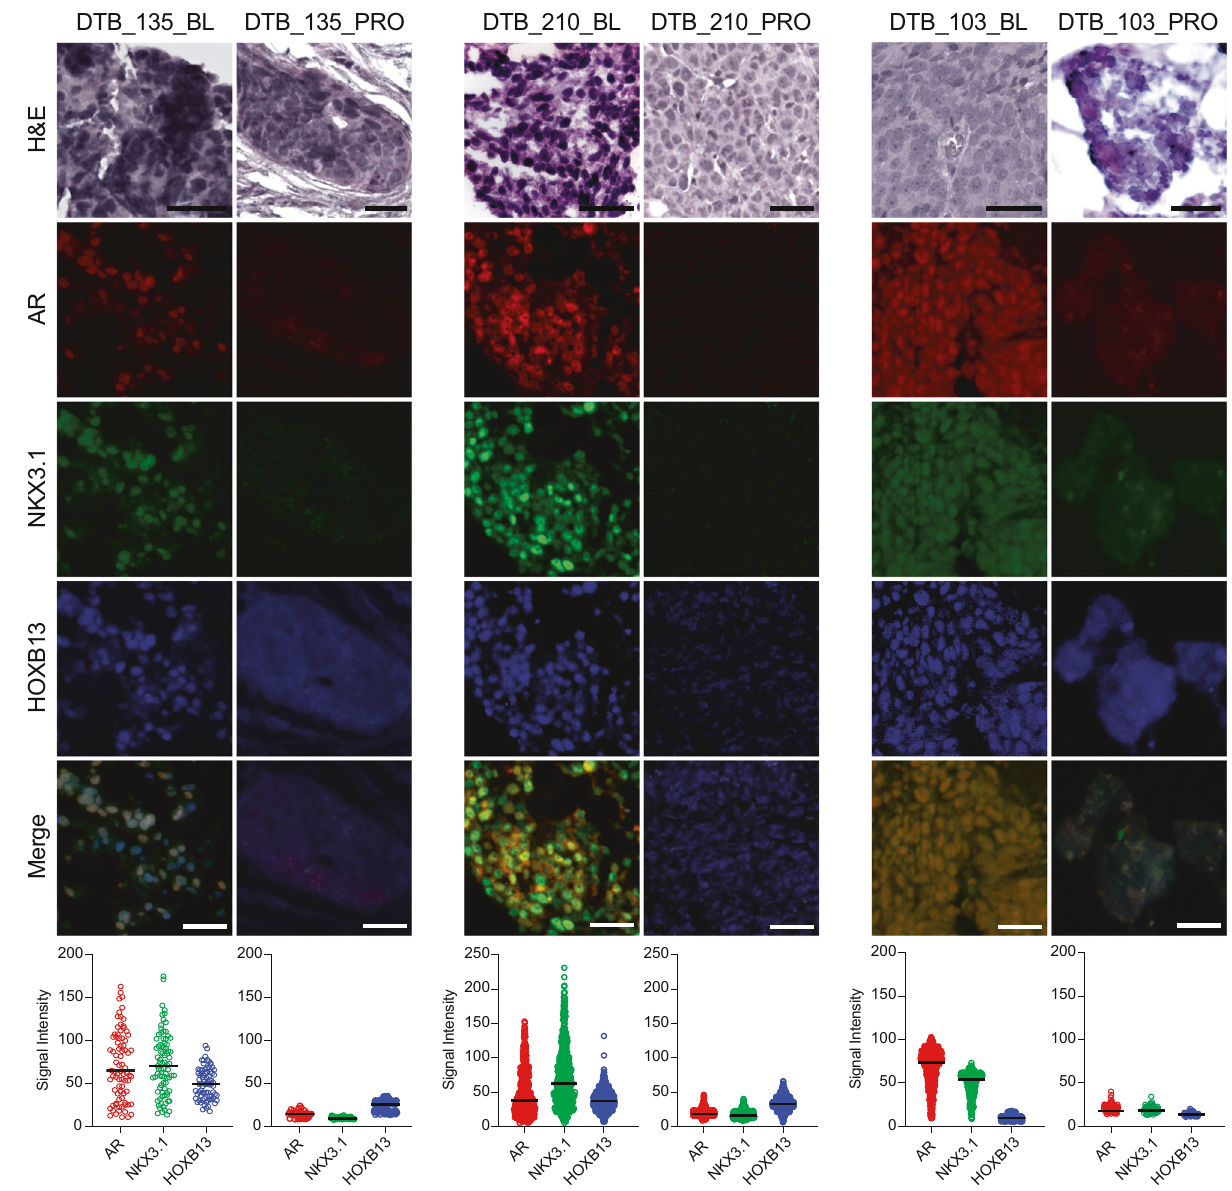
Fig.5|Multipleximmuno fl uorescencedemonstratesswitchtodoublenegative prostate cancer in samples undergoing lineage plasticity. Patients 135, 210, and an additional West Coast Dream Team patient whose tumor converted, patient 103, were stained for AR, NKX3.1, and HOXB13 expression ( n = 6 bio- logically independent samples with no replicates). The scale bar represents